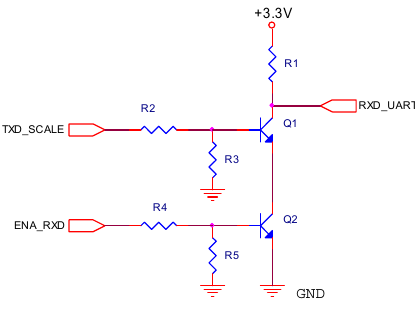
Figure 13. Adaptation circuit of levels RS-232 to 3.3V CMOS.